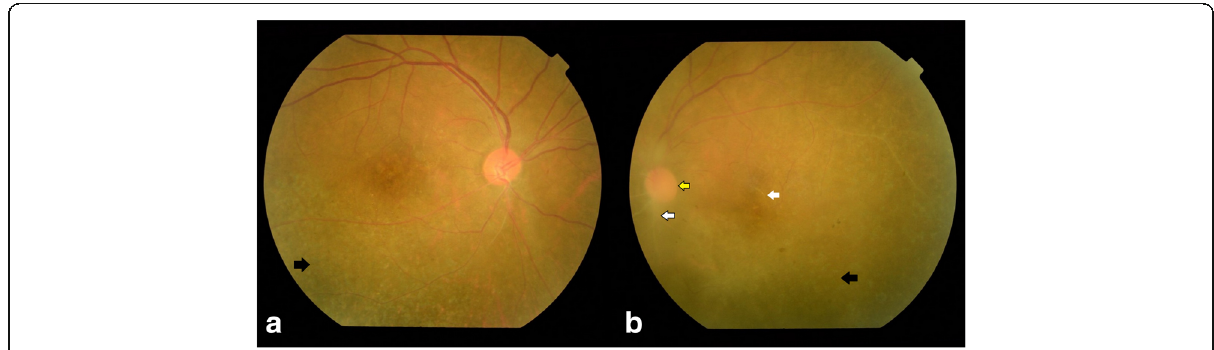
Fig. 7 Color fundus photo at 6 months follow up of a the right eye showing pigmentary alterations (black arrow) along the inferotemporal arcade and b the left eye showing disc pallor (yellow arrow with black border), sclerosed vessels (white arrow with black border), pigmentary alterations (black border), and epiretinal membrane (white arrow) at the macula with no evidence of recurrent active